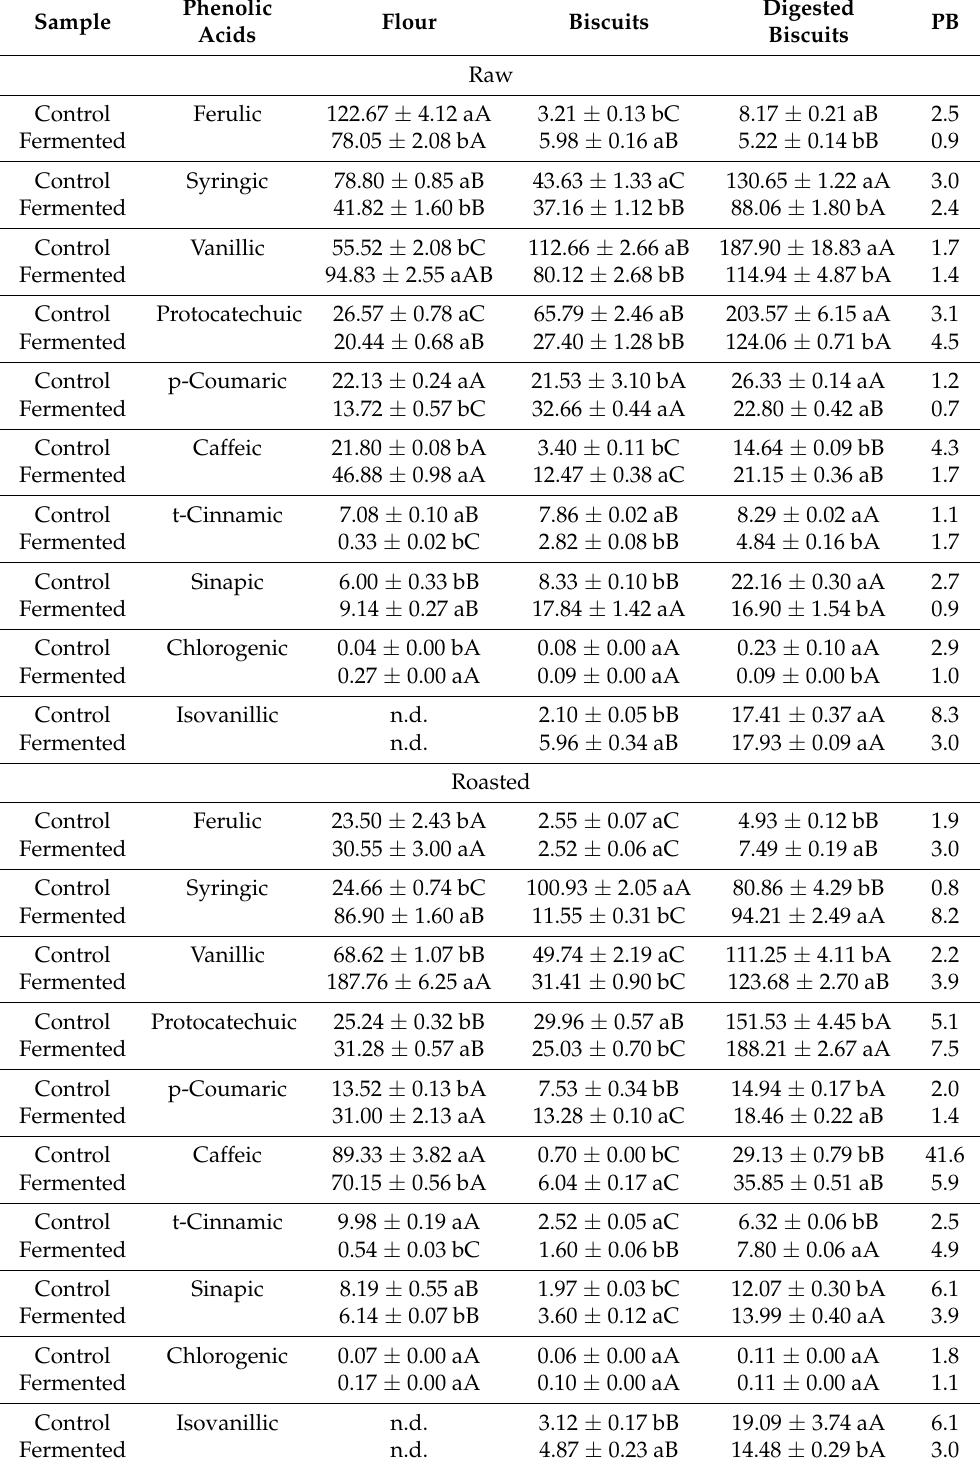
Table 2. The profile and content of phenolic acids ( µ g/g DM) and their potential bioaccessibility in raw and roasted buckwheat: flour, biscuits before and after in vitro